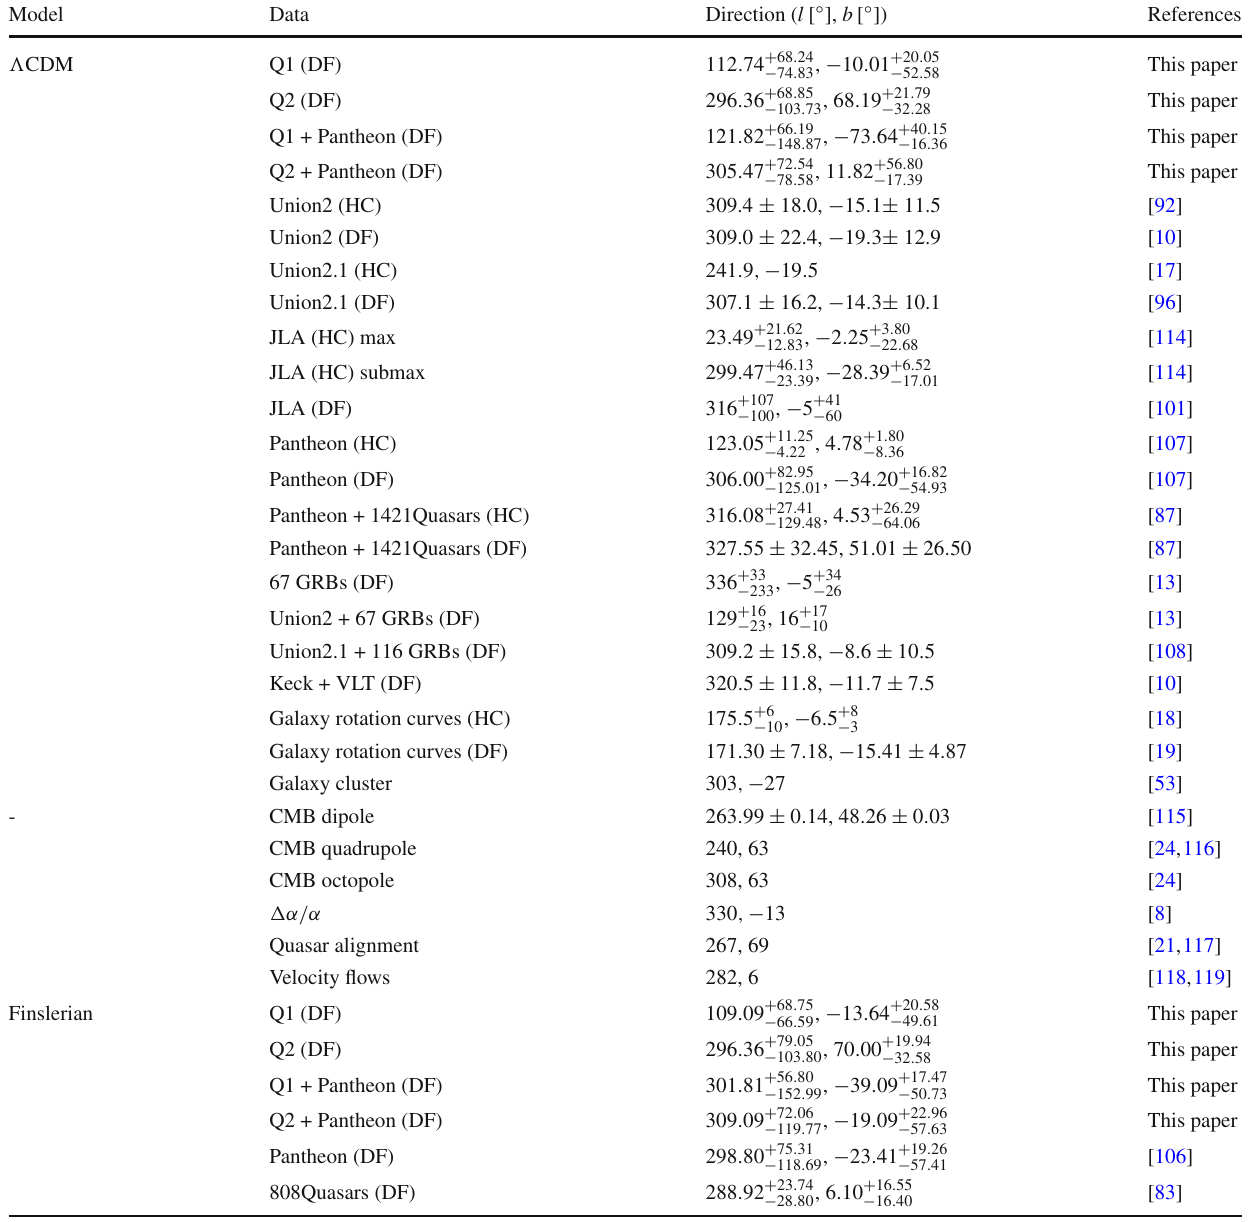
Table 4 The preferred directions derived from different samples